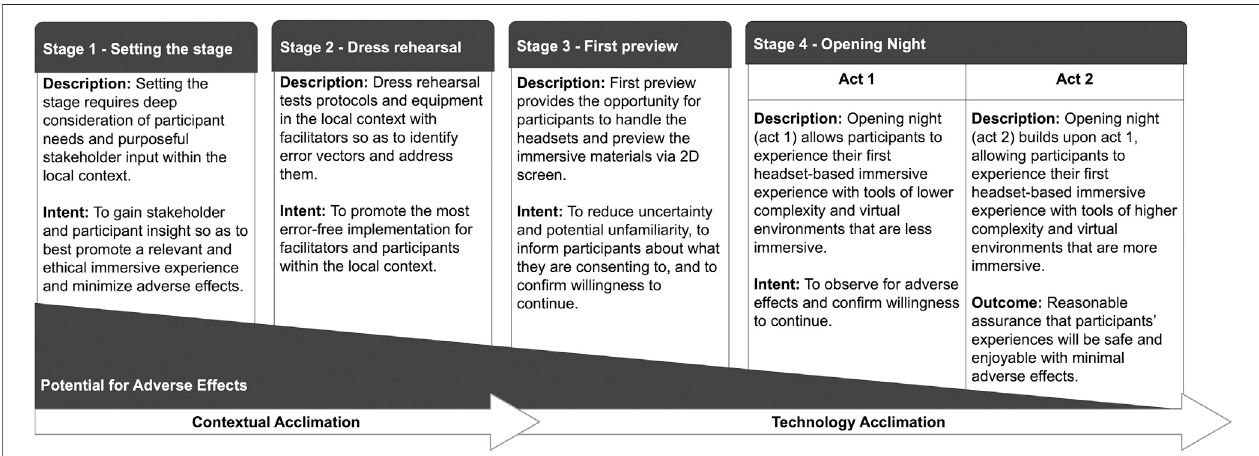
FIGURE 2 | Final stage-wise process model promoting gradual acclimation to minimize potential adverse effects of HMD-based VR for individuals with ASD.